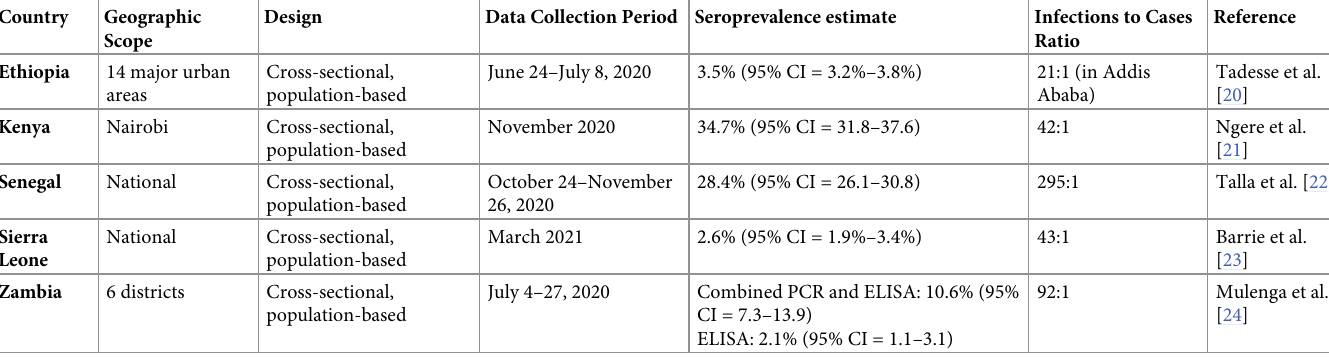
Table 2. Published CDC-supported SARS-CoV-2 international seroprevalence studies by February 28, 2022 (N =